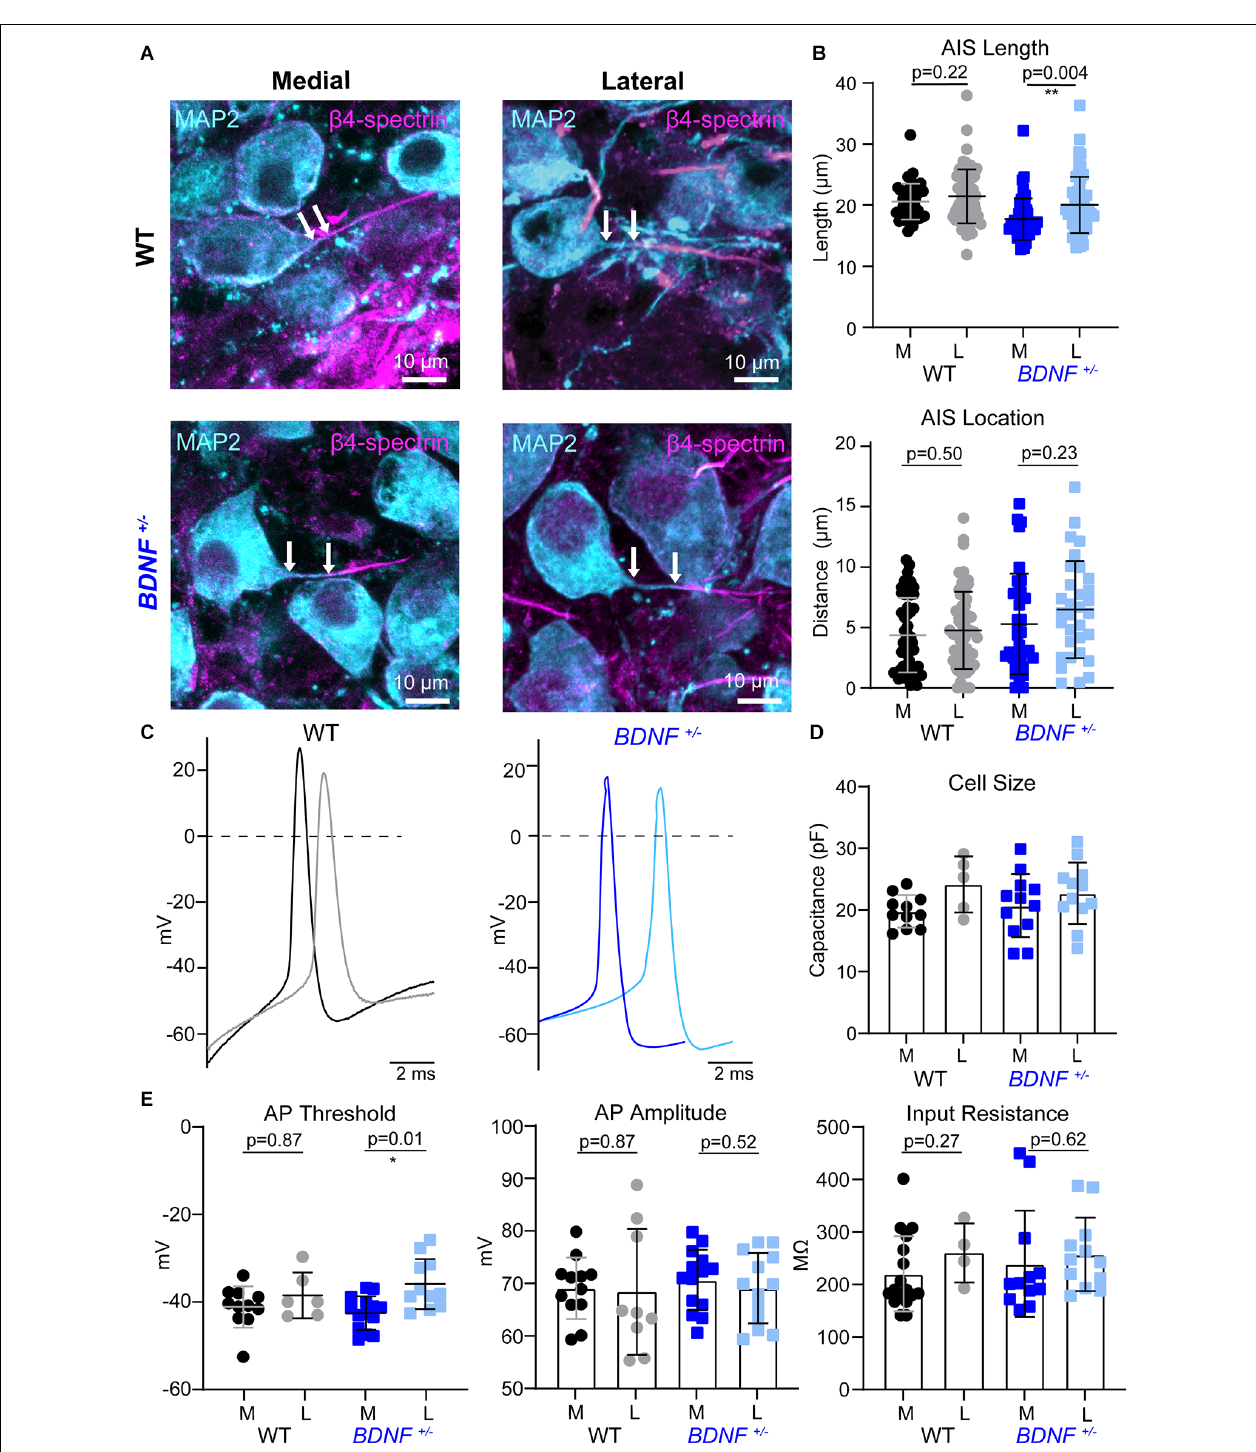
FIGURE 3 | AIS structures and intrinsic properties of MNTB neurons at pre-hearing age. (A) MNTB neurons (MAP2, cyan) and corresponding AIS ( β 4-spectrin, magenta) of WT and BDNF + / − mice (at P9). Scale bar represents 10 µ m. Arrows point to the edge of the soma and proximal end of the AIS, indicating the distance of the AIS. (B) Quantification of AIS location and length according to genotype and tonotopic location. Each point represents an individual cell from three mice/group. ** indicates p < 0.01. (C) Representative AP traces of medial and lateral neurons from WT and BDNF + / − mice. (D) Individual cell size was quantified by capacitance (pF) measurements during whole-cell recordings. Each point represents an individual cell. (E) Summary of AP threshold, amplitude, and input resistance by genotype and tonotopic location from five WT mice and four BDNF + / − mice. * indicates p < 0.05.